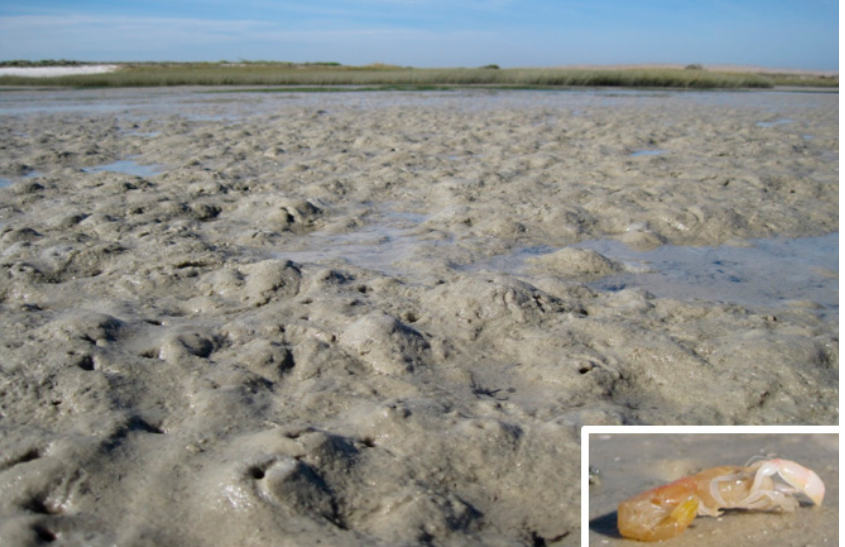
Figure 1. Irregular sediment topography created by engineering activities of the sandprawn Callichirus [as Callianassa ] kraussi in Langebaan Lagoon, on the west coast of South Africa. Mid-shore sandflats are shown in the foreground and high-shore marshes in the background. Photos courtesy of Jessica Dawson.